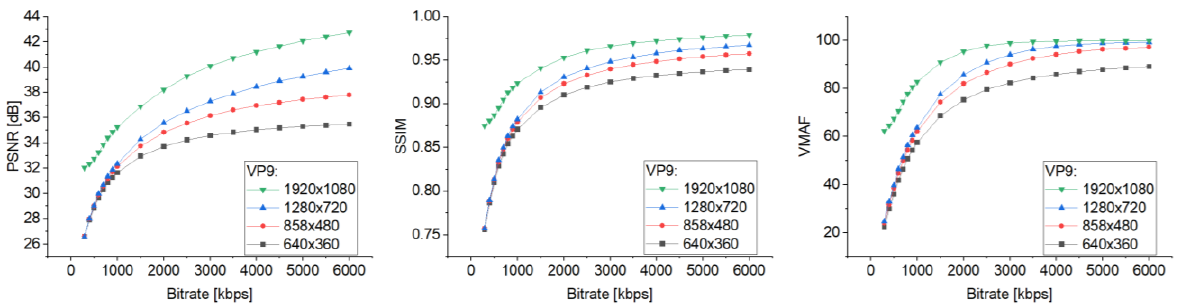
Figure 16. Relationship of the objective assessment of video quality encoded in the VP9 standard vs. bit rate for the resolutions 640 × 360, 858 × 480, 1280 × 720, and 1920 × 1080. Table 10. Correlations between QoS and QoE values (in the lab and home) for H.264 encoded video. QoS vs. QoE Correlations Lab